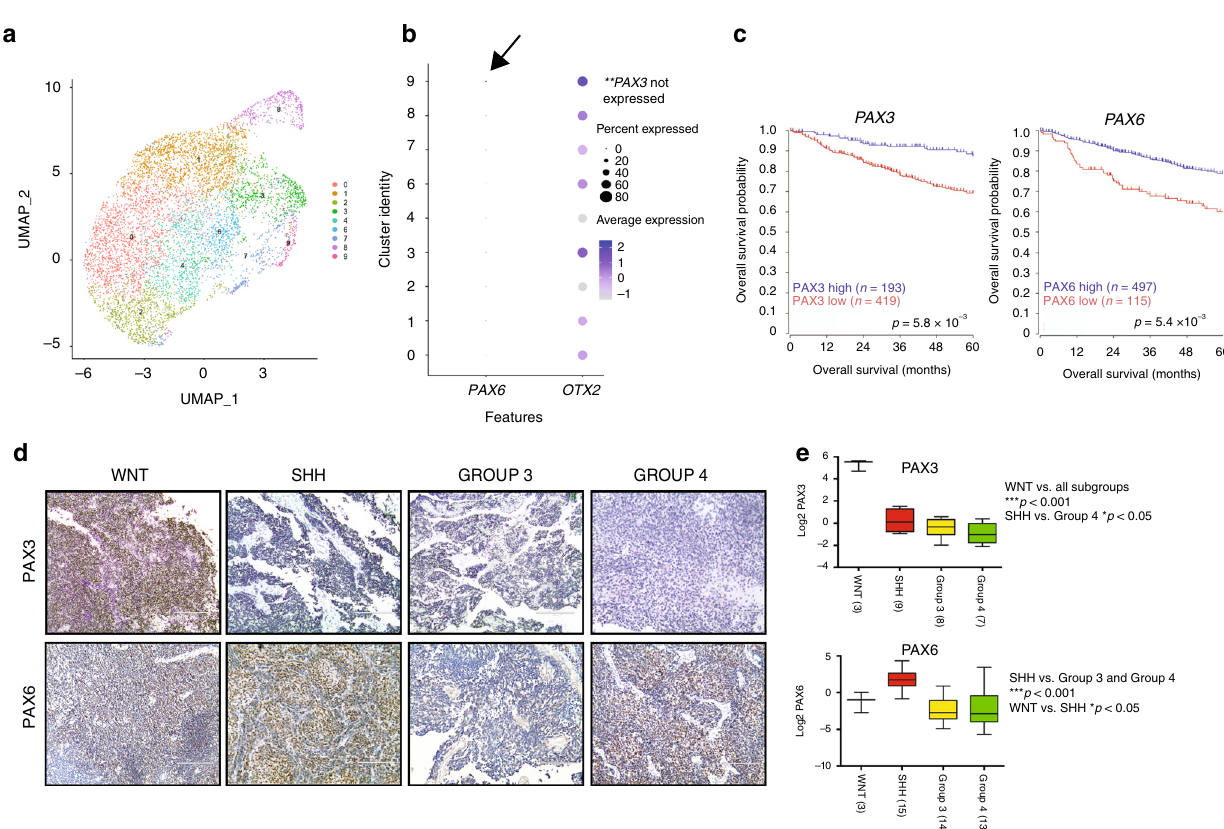
Fig. 2 PAX3 and PAX6 protein levels are lower in Group 3 MB, and lower expression of both genes is associated with reduced survival in patients. a Nine transcriptionally distinct cell populations from two Group 3 MB patient samples as previously de fi ned 11 . Of note, clusters 5, 10, and 11 were classi fi ed as non-tumor clusters and removed for downstream analysis. b Dot plot demonstrating the frequency and average expression of PAX6 (left) and OTX2 (right) within nine transcriptionally distinct cell populations from N = 2 Group 3 MB patient samples. Arrow denotes minimal expression of PAX6 in cluster 9. PAX3 was not detected in this dataset. c Low expression of both PAX3 and PAX6 is associated with signi fi cantly reduced overall patient survival in N = 612 MB patient samples. p -Values were determined using the log-rank method. d Representative images of PAX3 and PAX6 staining in FFPE sections from all four MB subgroups. Scale = 200 μ m. e Proteomic analysis (Boston cohort) demonstrates low expression of PAX3 ( N = 27 patient samples) and PAX6 ( N = 45 patient samples) in Group 3 MB. For PAX3: WNT vs all other subgroups, *** p < 0.001, SHH vs Group 4: * p < 0.05, all other pairs NS. For PAX6: WNT vs SHH, * p < 0.05, SHH vs Group 3 and Group 4 *** p < 0.001, all other pairs NS. Signi fi cance was determined by one-way ANOVA.